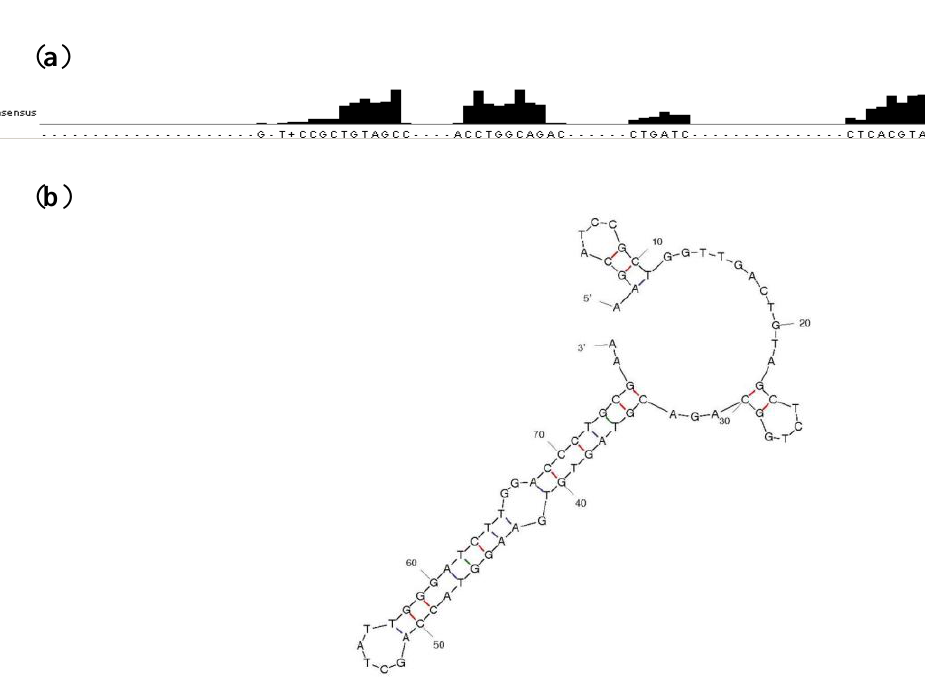
Figure 2. ( a ) Common motifs shared between the 47 clones of the enriched pool at round 15. Alignment was performed without including the primer regions. Sequence analysis was carried out using ClustalW2 [34]. ( b ) A predicted structure of R15/19 by Mfold